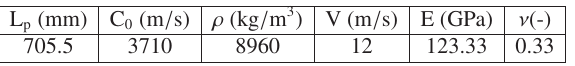
Fig. 2. Recorded waves from the simulation. Table 1. Mechancial and Physical properties of Copper bars and striker.